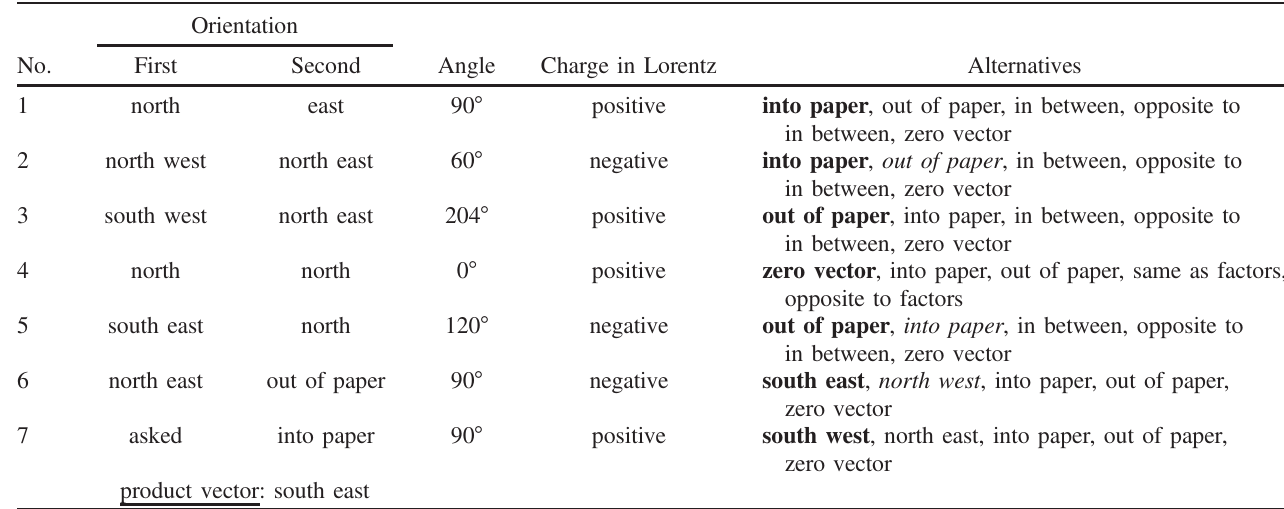
TABLE I. Overview of the orientation of, and the angle between the vectors in seven questions on the test, as well as the sign of the charge in the Lorentz version and the alternatives the students could chose from. The correct alternatives are indicated in bold, or in italics for the Lorentz version if it is different from the other test